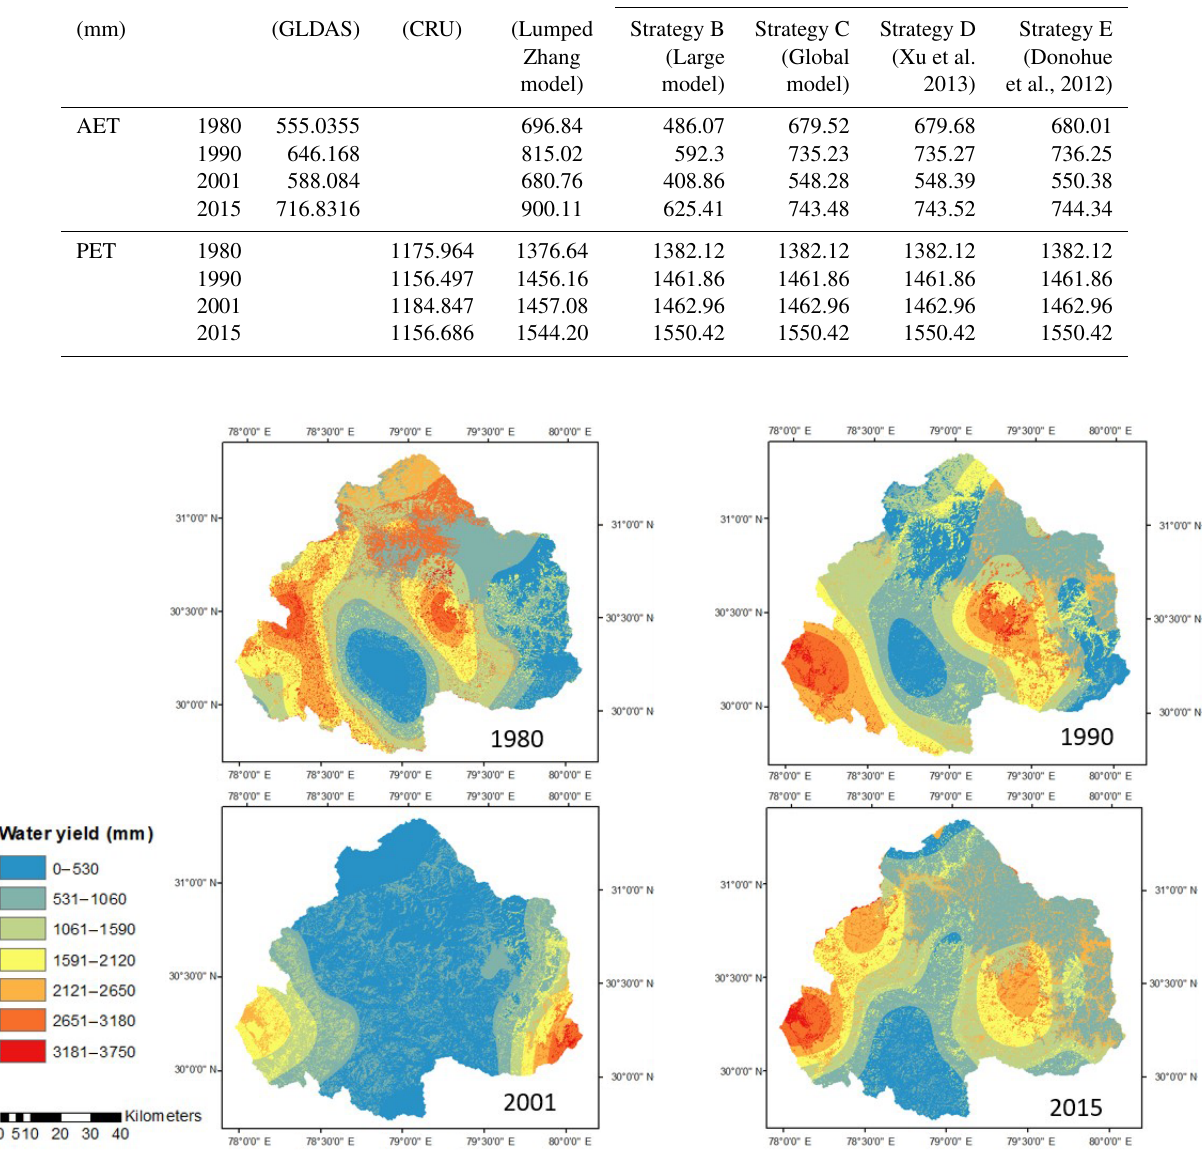
Figure 4. Water yield obtained by taking the single weighted mean value of parameter w from Xu et al. (2013) for large